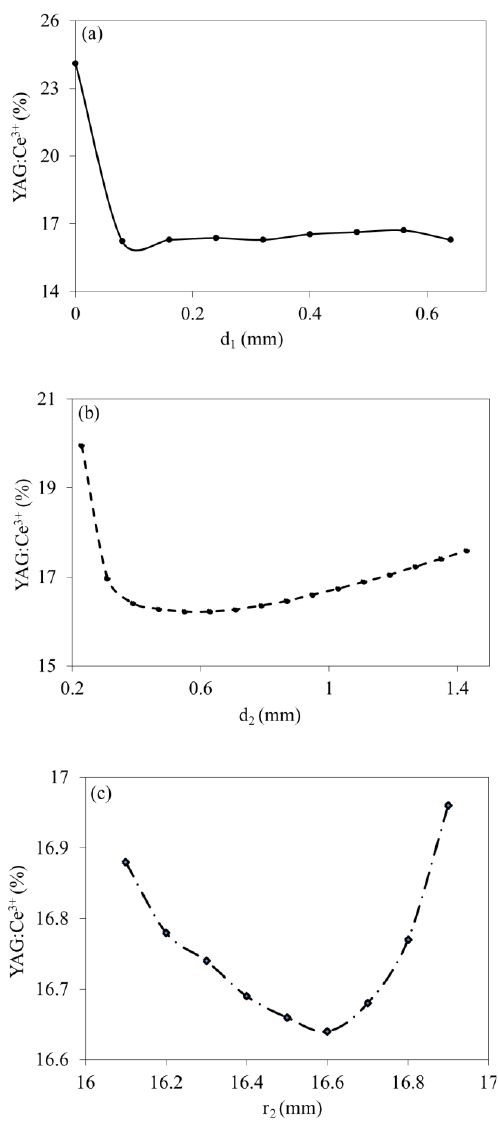
Figure 2 : The concentration of yellow phosphor in case of d 1 (a); d 2 (b) and r 2 (c)